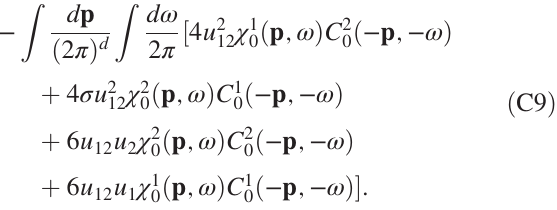
˜ ϕ ˜ ϕ ϕ ϕ 3 2 2 , u 2 2 and 2